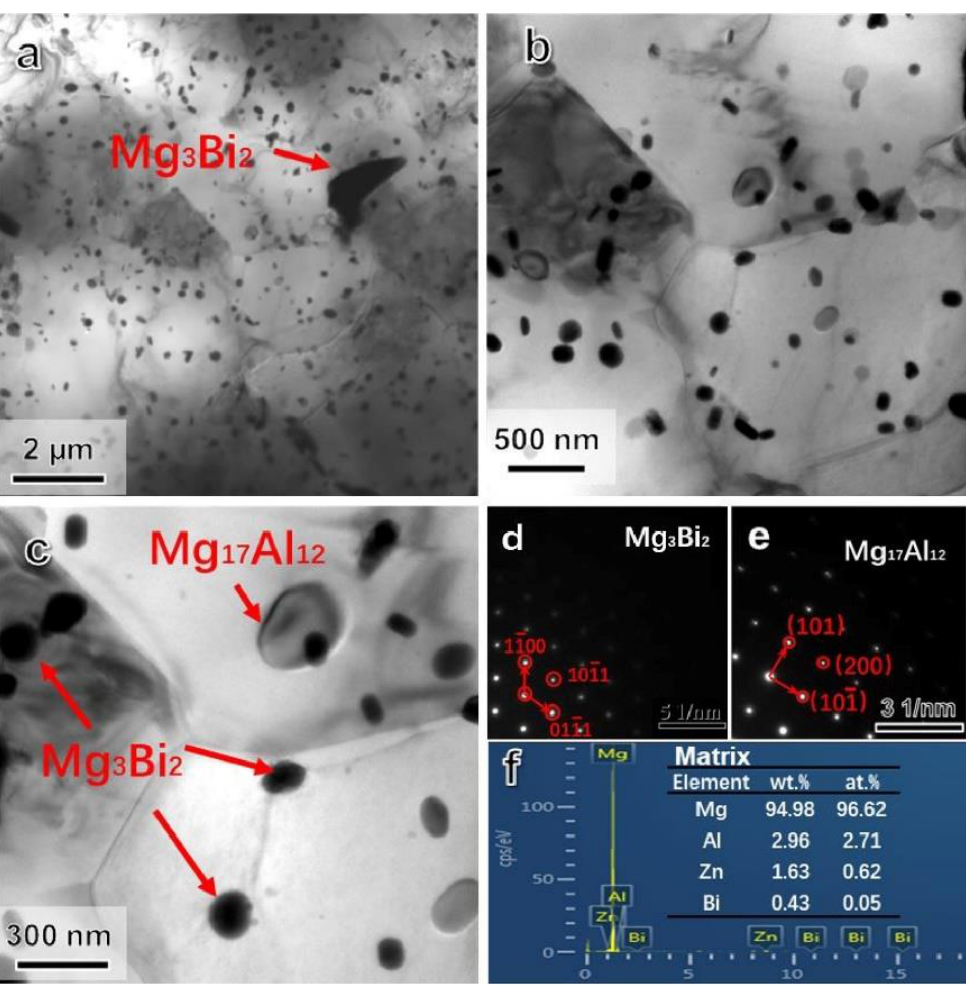
Figure 4. TEM images of as-extruded BAZ631 alloy at low ( a ) and high ( b , c ) magnification, selected area diffraction patterns of ( d ) Mg 3 Bi 2 and ( e ) Mg 17 Al 12 precipitates and ( f ) EDX analysis of matrix.